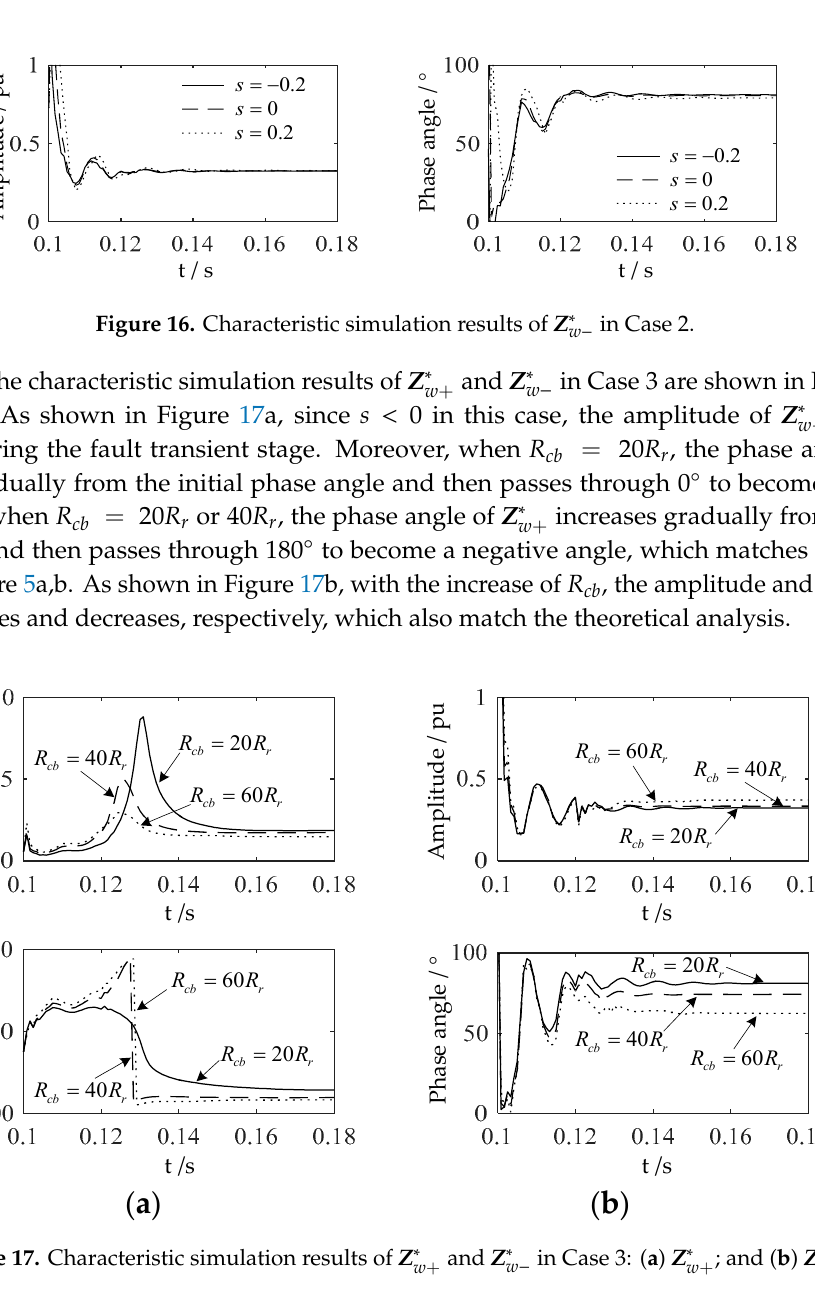
Figure 17. Characteristic simulation results of